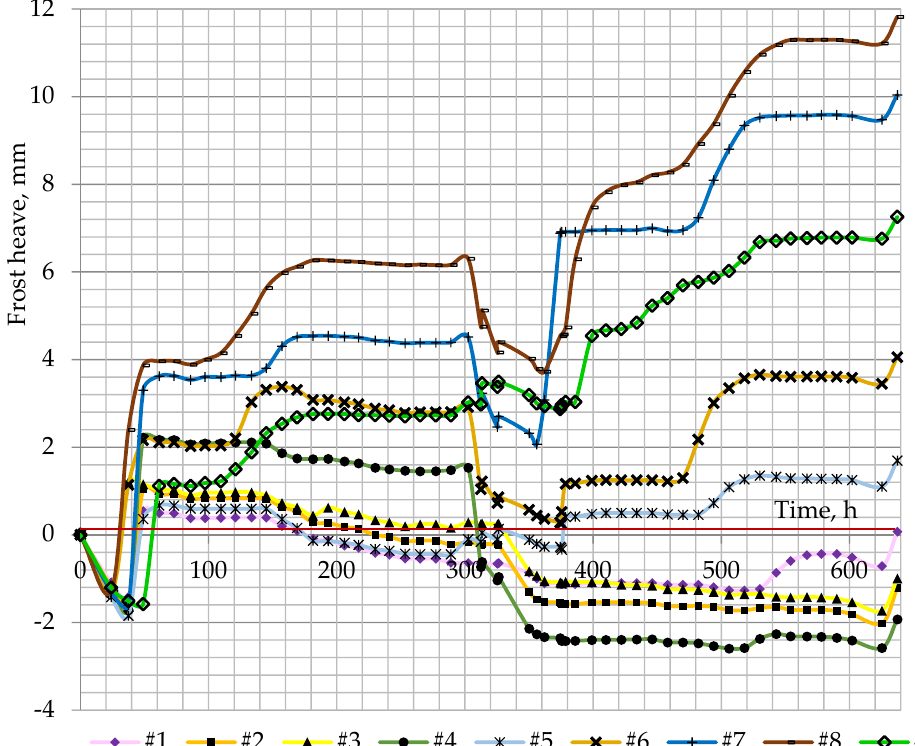
Figure 8. Frost heaving in soil samples over time. The dry density change in soil samples during two freeze–thaw cycles are presented in Figure 9. The columns with loose densities were consolidated throughout the column length with the densest part in the bottom of the samples. In comparison, in the dense soil samples only the 10 cm layer on top was loosened, which also attracted a large amount of water to form ice lenses.